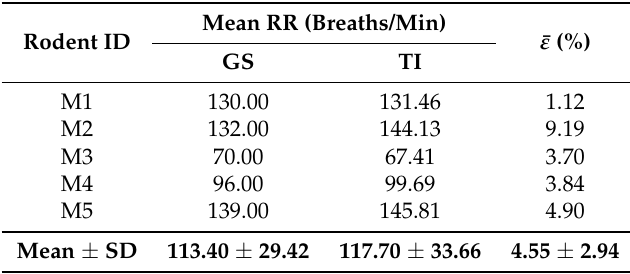
Table 2. Results for RR estimation in thermal videos from mice. Mean RR Rodent ID